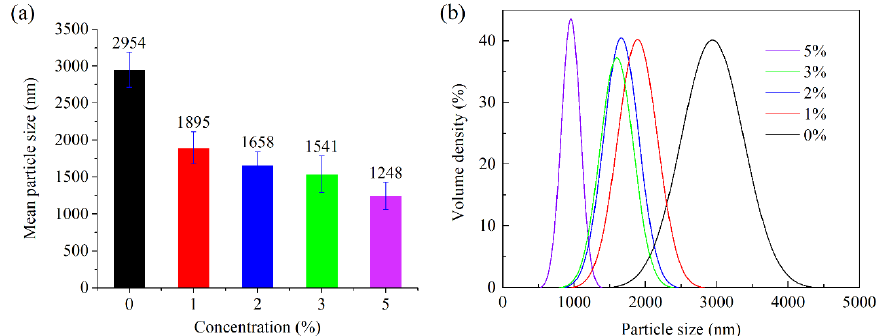
Figure 6. Effect of different concentrations of TQ-1 on the mean particle size of the emulsion. ( a ) mean particle size (error bars represent standard deviation), with the standard deviation values ranging from 182 to 247 nm based on the TQ-1 concentration; ( b ) particle size distribution curves.